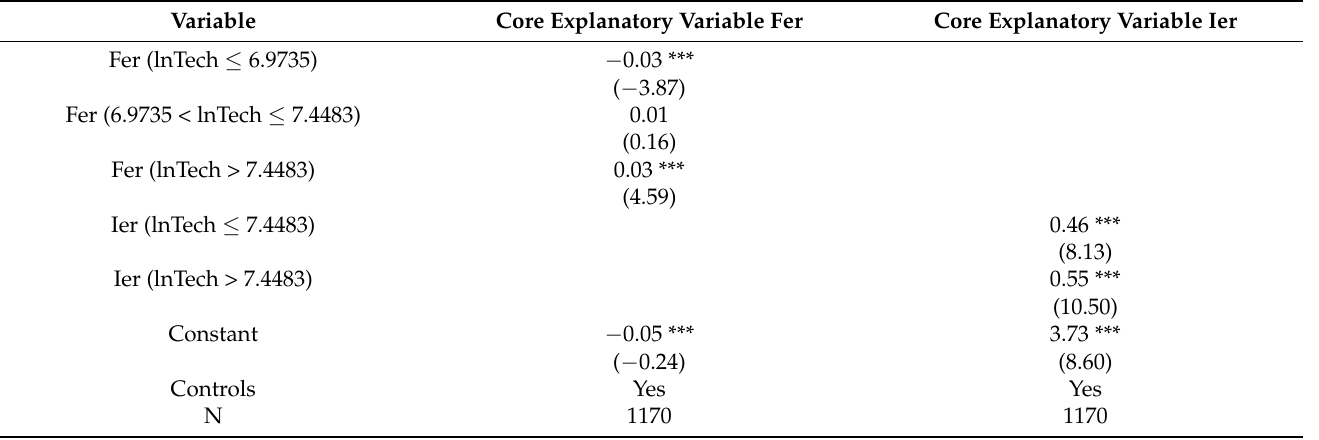
Table 6. Panel threshold regression